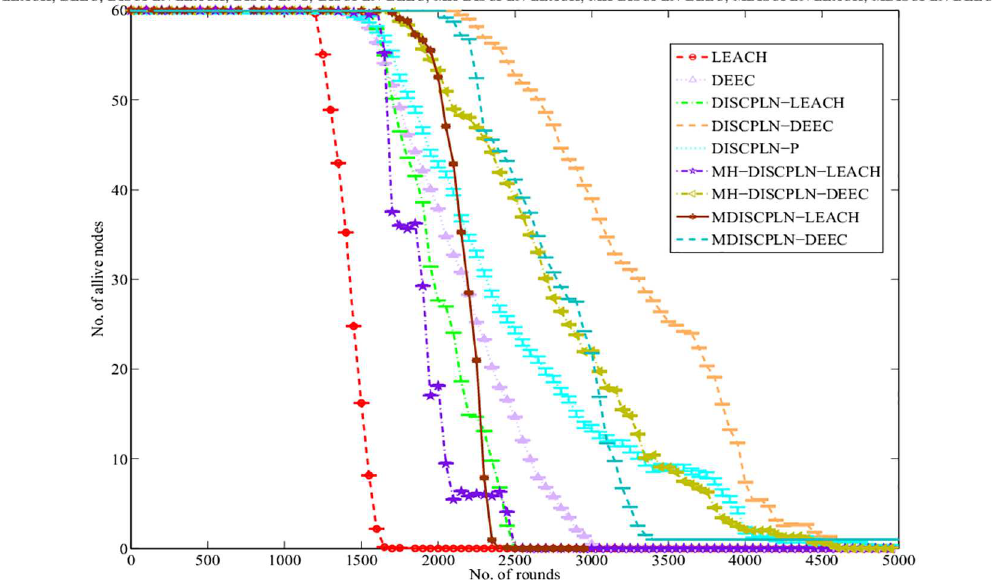
Fig 15. Performance comparison on the basisof alivenodes.